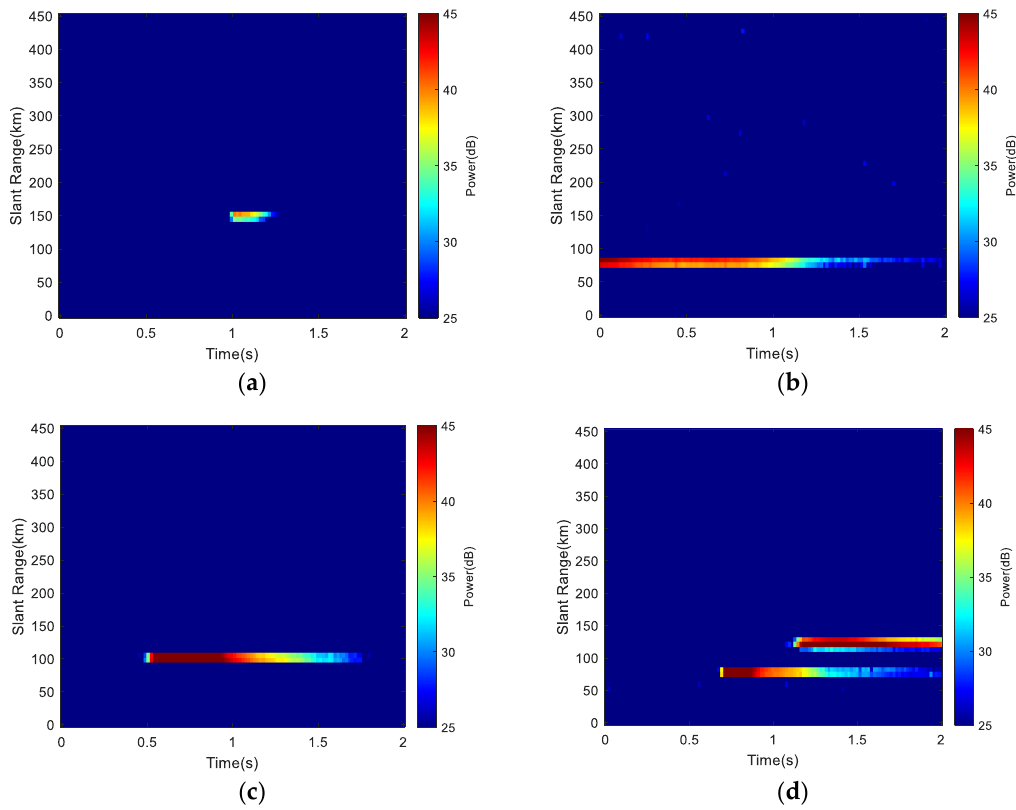
Figure 3. Typical meteor echo characteristic. ( a ) Short-duration meteor echo, ( b ) Long-duration meteor echo, ( c ) Can see the entire cycle of the meteor echo, ( d ) Two meteor echoes at different slant ranges.